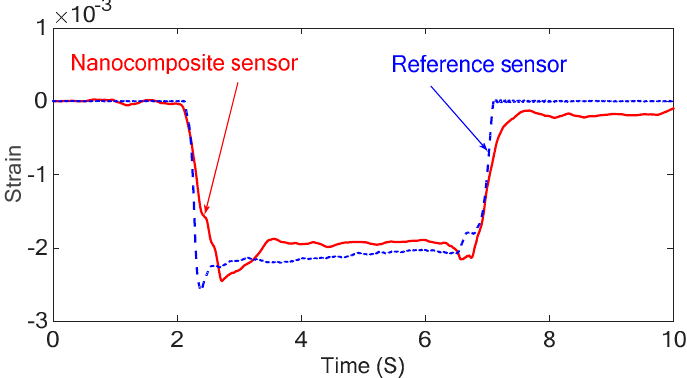
Figure 17. The piezoresistive response of the system under static loading obtained from the nanocomposite sensor and the metal foil strain gauge.